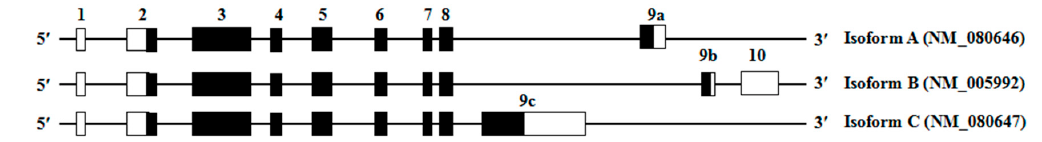
Figure 1. The schematic genomic structure of the TBX1 gene and locations of molecular variants analyzed in this study. The black box indicates the protein ‐ coding region; the white box indicates the untranslated region. Table 1. Genotype and allele frequencies of molecular variants of the TBX1 gene in patients with schizophrenia (SZ) and control subjects (Ctrl).